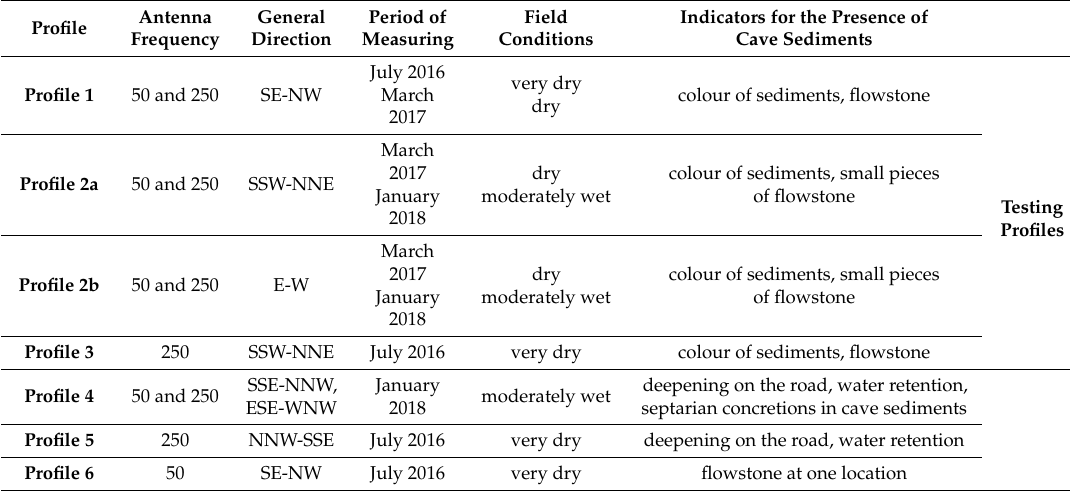
Table 1. Presented profiles with basic characteristics.